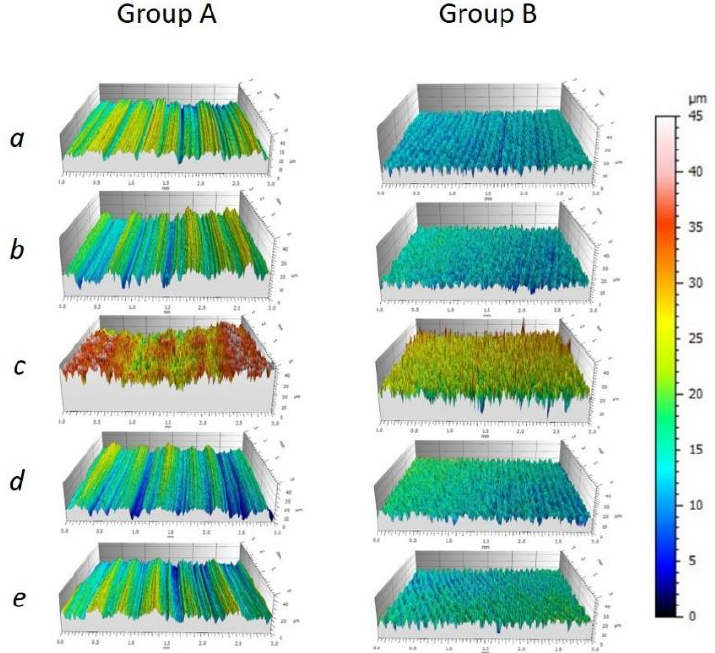
Figure 5. Exemplarily surface roughness profiles for Groups A and B showing the reference ( a ), MMA ( b ), sandblasted ( c ), oxygen plasma ( d ), and nitrogen plasma ( e ).